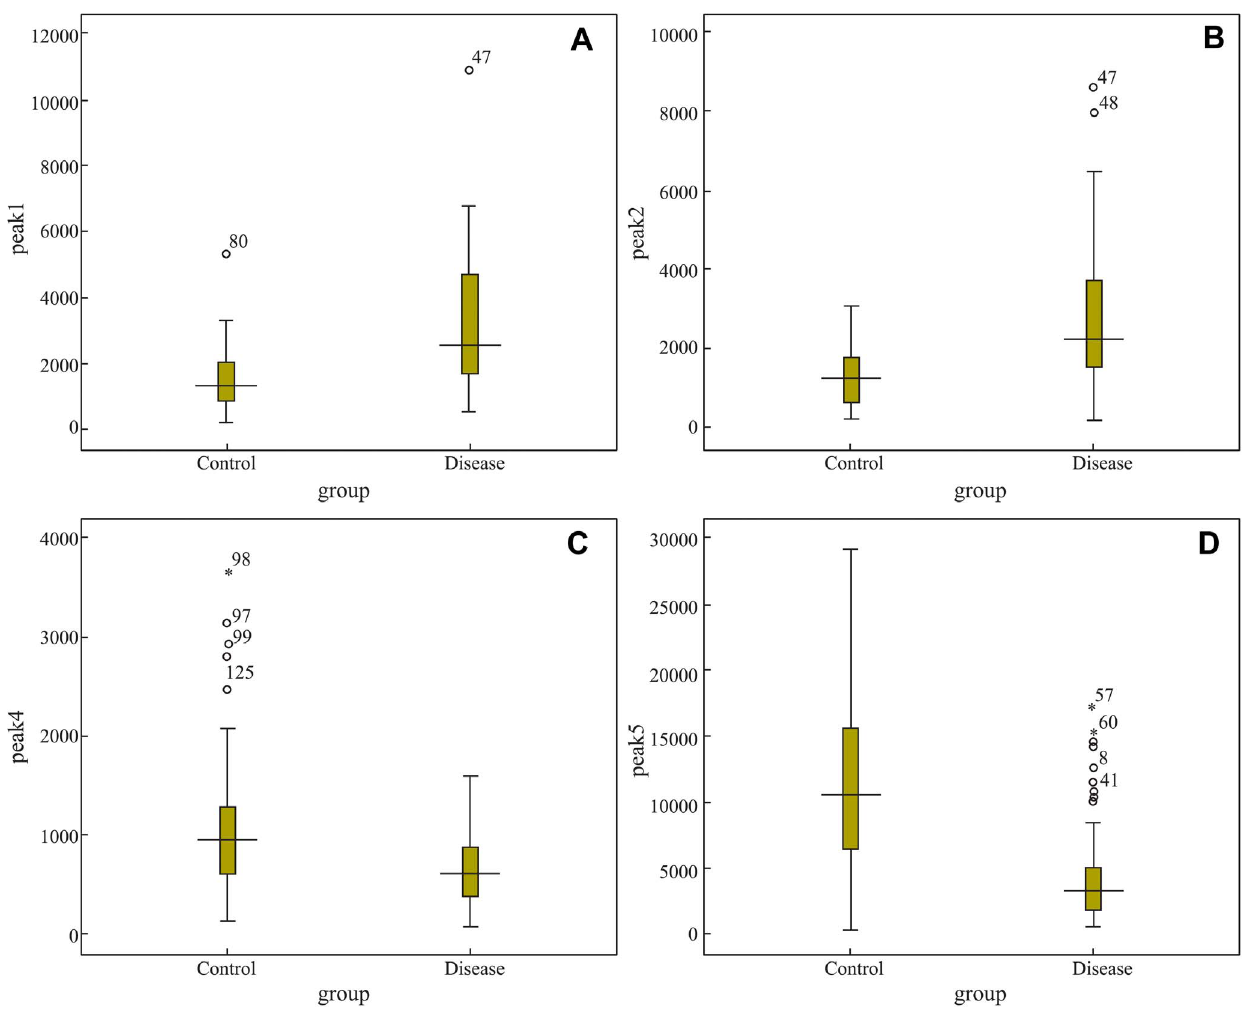
Figure 3. Box-blot of the discriminatory peak signal-intensities. (A), (B), (C), (D) refer to signal-intensities of peaks1, 2, 4 and 5, respectively.